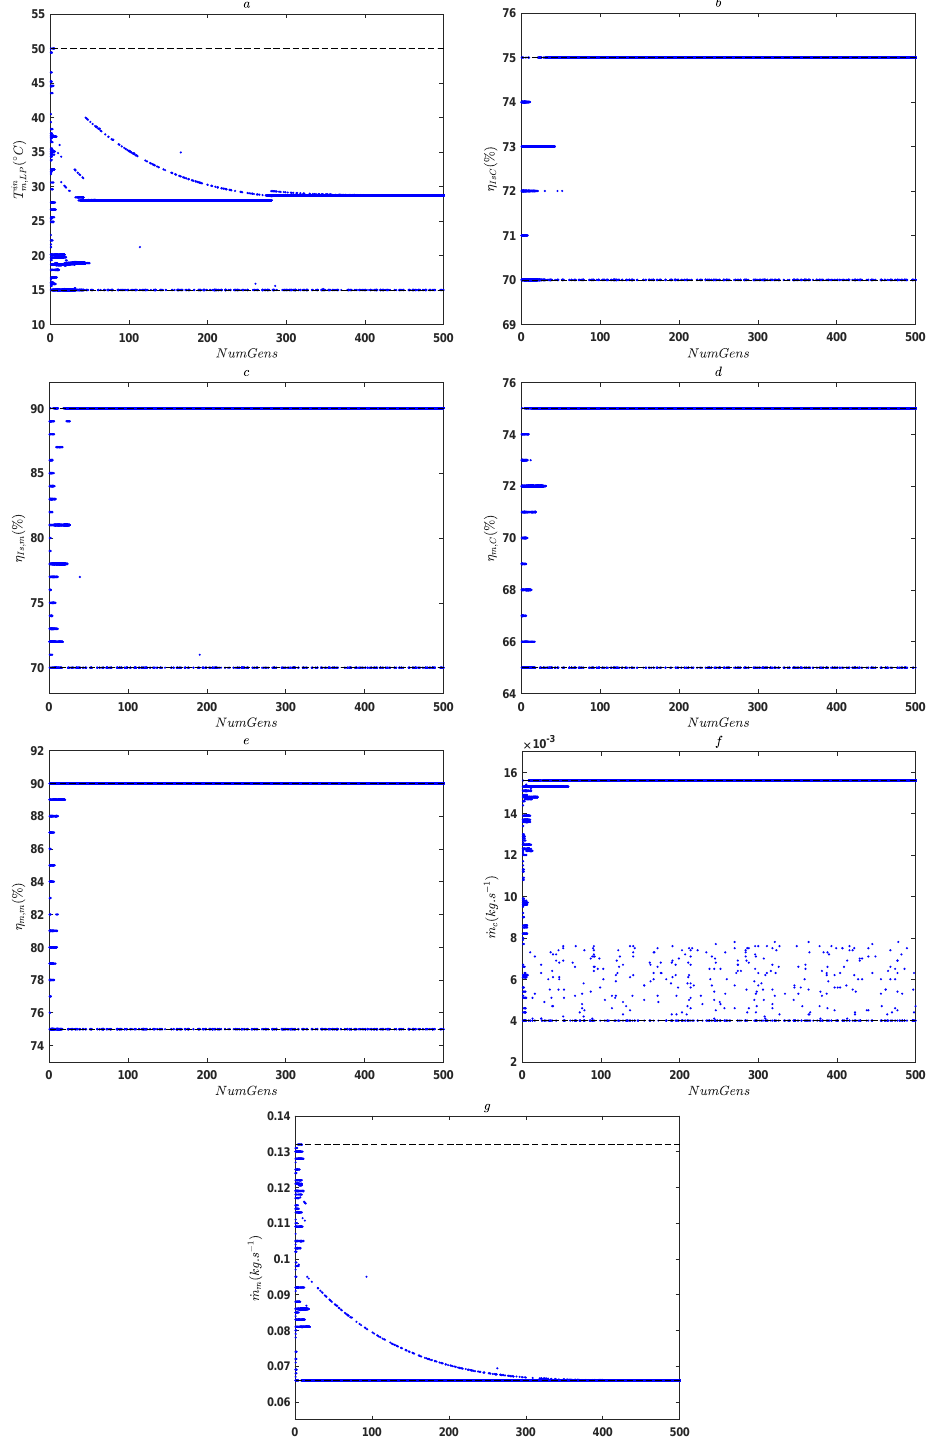
Figure 9. Scattering of optimal design variables during evolution; the inlet temperature of the low-pressure expansion stage ( a ), of the isentropic efficiency of compressor ( b ), of the isentropic efficiency of pneumatic motor ( c ), of the mechanical efficiency of compressor ( d ), of the mechanical efficiency of pneumatic motor ( e ) of the compressor motor mass flow rate ( f ) and of the pneumatic motor mass flow rate ( g